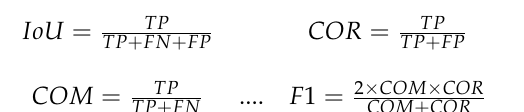
0 . Figure 15. IoU scores of the methods in Figure 14.